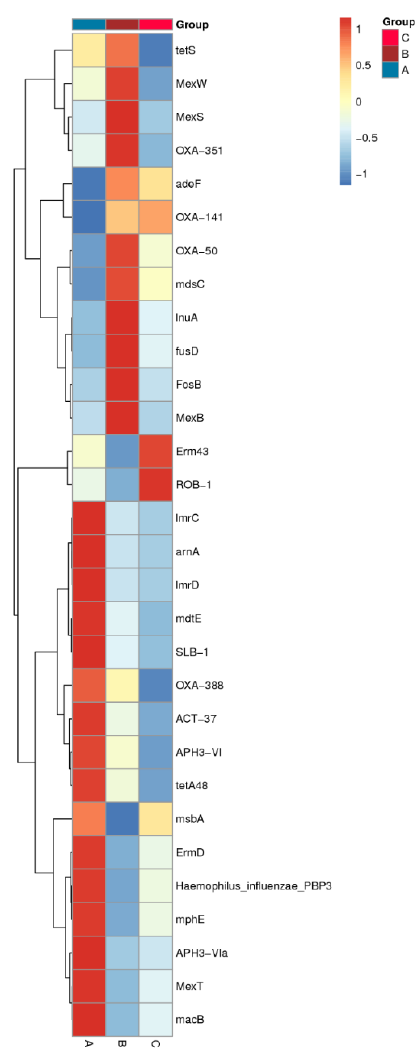
Figure 7. Heatmap of variations of ARGs based on relative abundance across three samples. The top 30 ARGs are shown. The right vertical axis is the ARG name, the clustering tree on the left vertical axis is the clustering tree of ARG, and the corresponding value of the heatmap is the Z value of the relative abundance of each row of ARG after normalized processing.